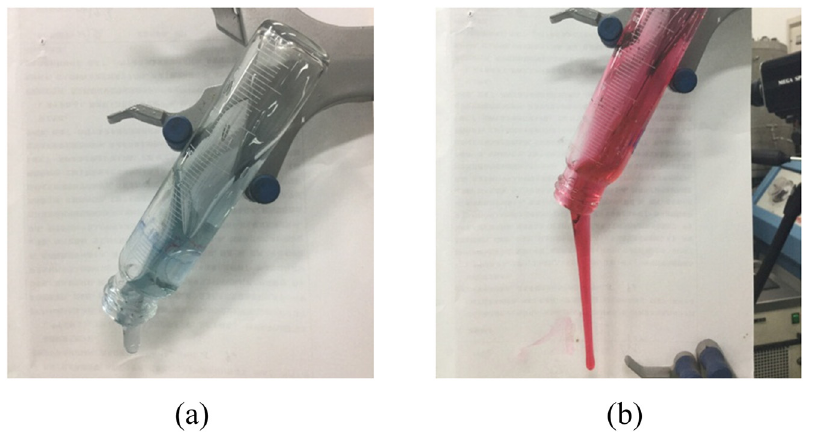
Figure 6: E ff ect of Cr 3 + concentration on polymer gel. ( a ) Cr 3 + concentration: 357.5 mg/L, ( b ) Cr 3 + concentration: 200 mg/L.